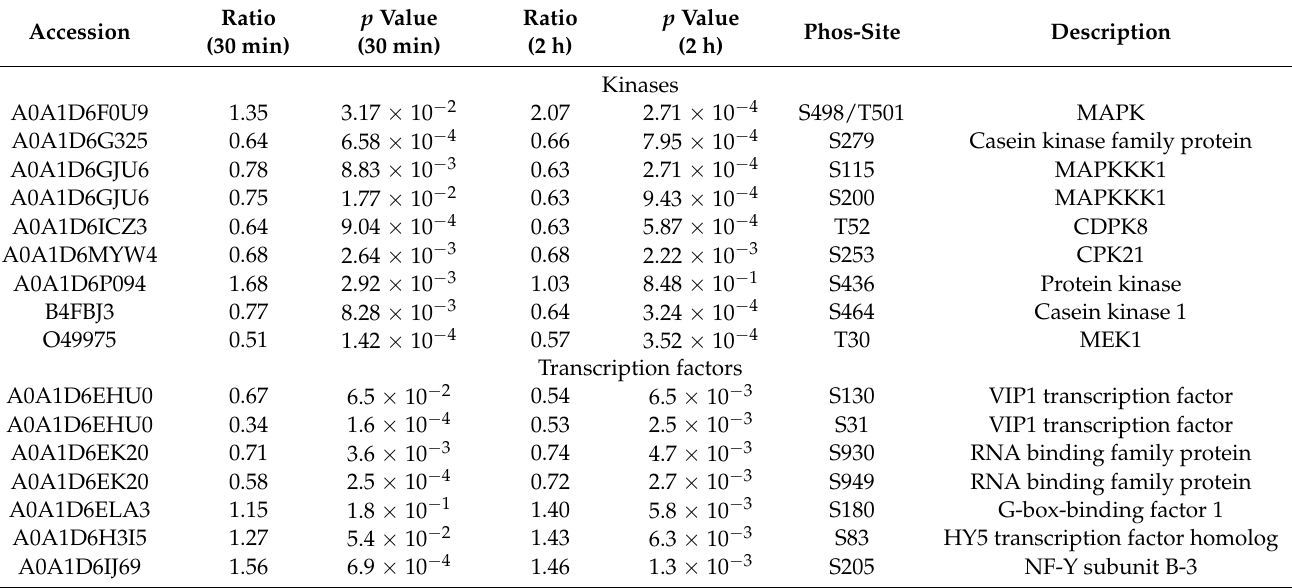
Table 2. Cold-responsive kinases and transcriptional factors (at site-specific phosphorylation levels). “Ratio” refers to phosphorylation level ratio of treated/control. “ p -value” refers Benjamini–Hochberg corrected p